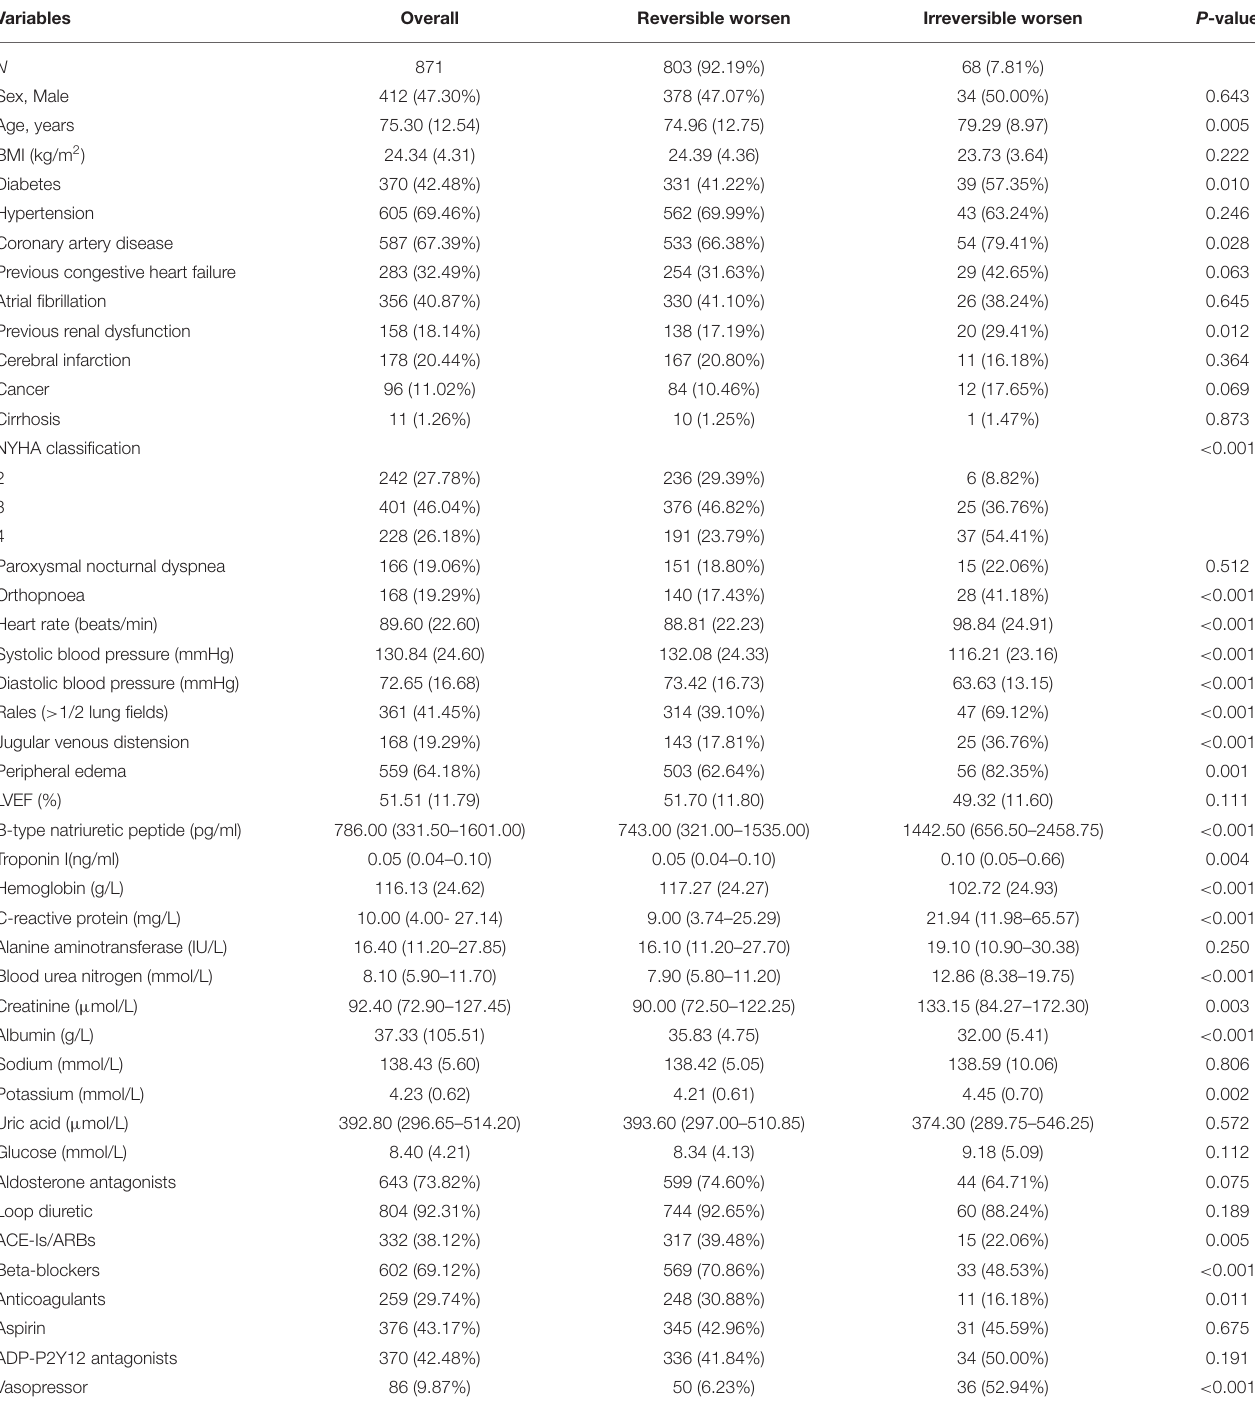
TABLE 1 | Comparison of the characteristics between the reversible worsen and irreversible worsen groups.